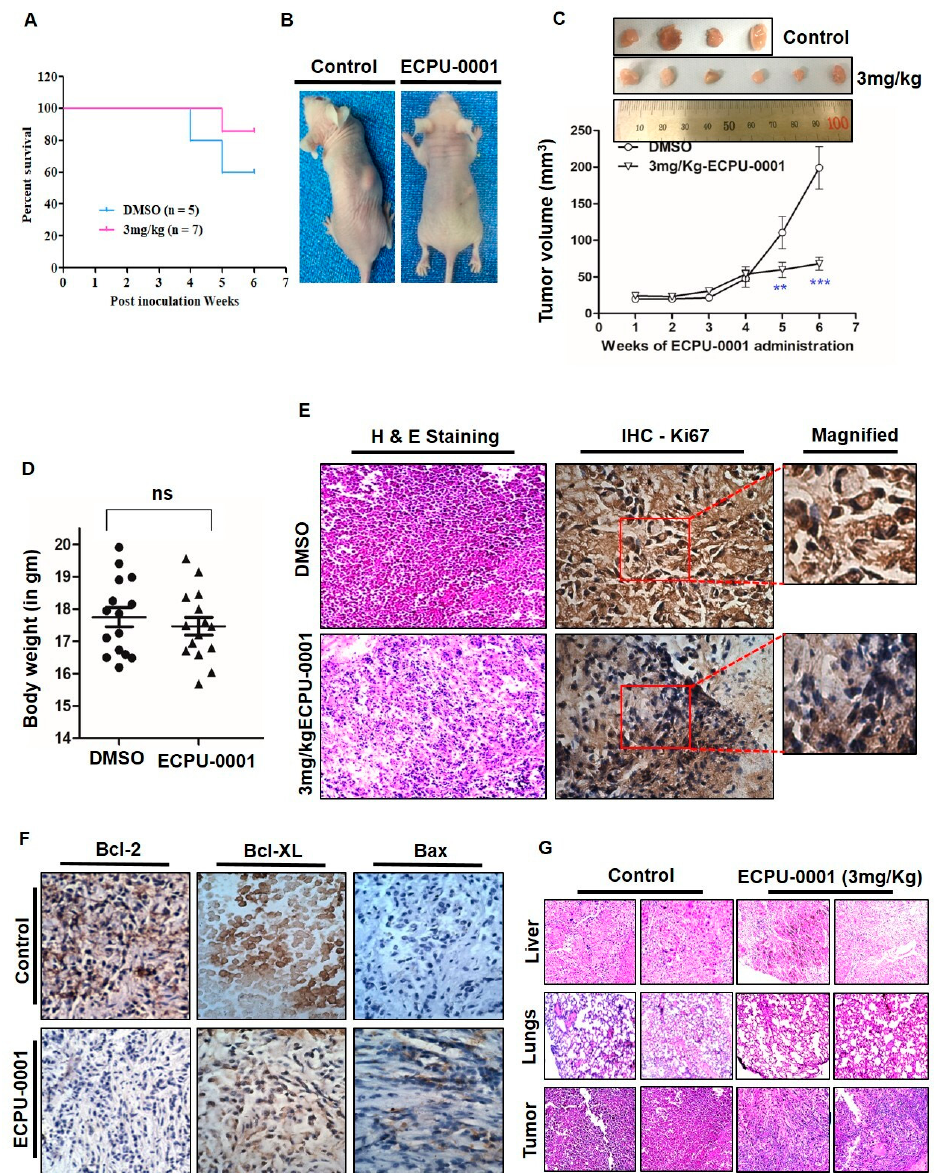
Figure 7. ECPU-0001 inhibits tumor growth and reduces tumor burden in xenograft nude mouse model. ( A ) Mice were euthanized when tumor volume reached 220 mm 3 , and survival is shown in a Kaplan-Meier plot ( p < 0.05). ( B ) ECPU-0001 inhibits A549-lung cancer tumor growth and metastasis in in vivo subcutaneous xenograft model. ( C ) BALB/c nude mice inoculated with 2.5 × 10 6 A549 cells in right/left flanks were administered 3.0 mg/kg of ECPU-0001 or DMSO as a control, two times a weekly for six weeks. Tumor volume was measured every third day. Data shown are mean ± SD ( n = 7; ** = p < 0.01, *** = p < 0.001). ( D ) Body (gm) weight was measured once a week during the experiment. ( E ) Immunohistochemistry of oncoprotein Ki67 in tumor sample slides (Magnification: 400X). Tumor-bearing nude mice were administered with ECPU-0001 and DMSO every alternate day for six weeks. Then solid tumors were collected after the mice sacrificed and process for IHC histopathological analysis. Tumor volume and area were recorded from each tumor. Left panel showing ECPU-0001 efficacy in A549 induced tumor sections by H & E staining. ( F ) Tumoricidal activity of ECPU-0001 with minimal cytotoxicity via induction of apoptosis in vivo. Here, elucidated the histopathology of xenograft tumors. The tumor sections were under IHC staining using specific antibody against BCL-